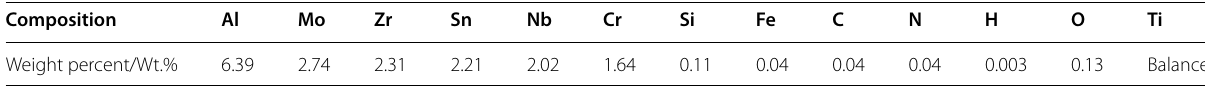
Table 1 Chemical composition of TC21 Ti-alloy Composition Weight percent/Wt.%